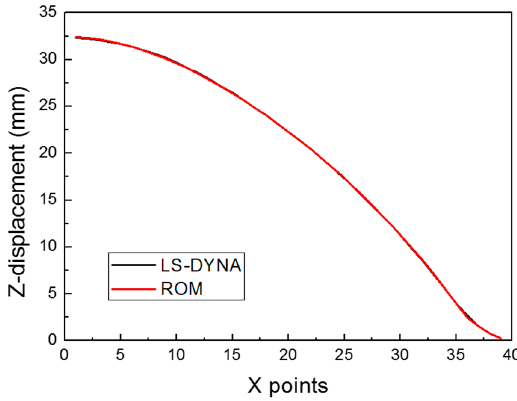
Figure 11. Dominant eigenvectors for the EHF simulation.